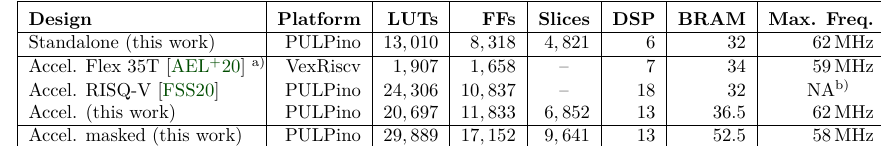
Table 5: Resource overview and estimated max. frequency for the system with and without accelerators (measurements of this work evaluated for Artix 7 FPGA XC7A100T). Design